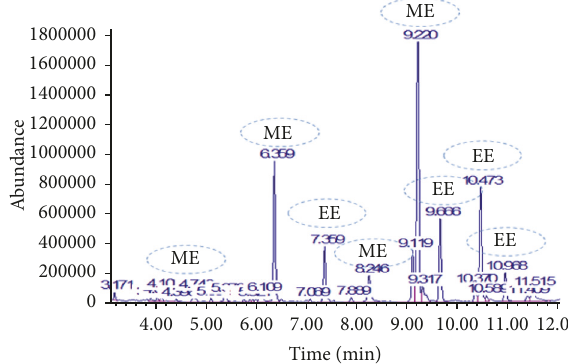
Figure 8: Chromatograms of biodiesel obtained by whole-cell transesterification of beef fats. EE: ethyl ester, ME: methyl